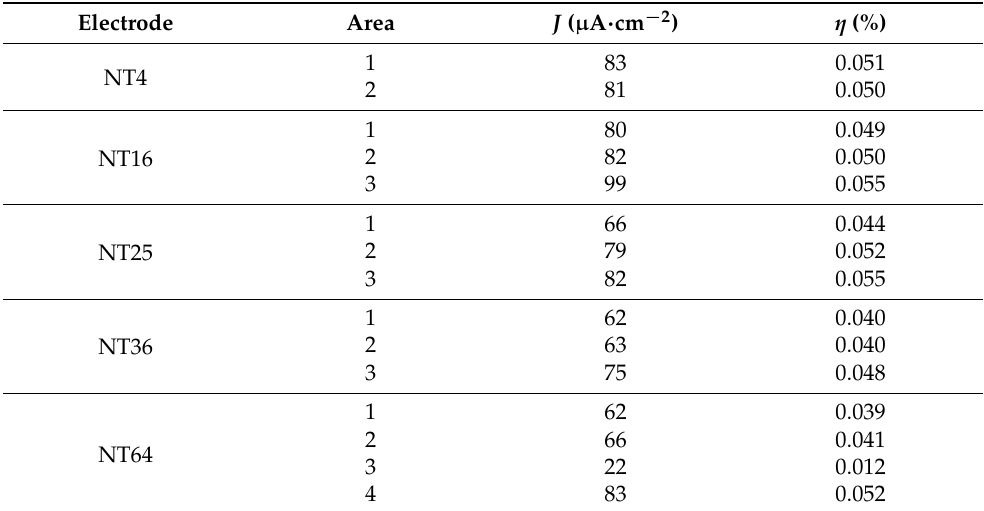
Figure 6. Transient photocurrent responses and SEM at various places on the NT64. Table 2. Density and conversion efficiency values registered for each sample in different places of the